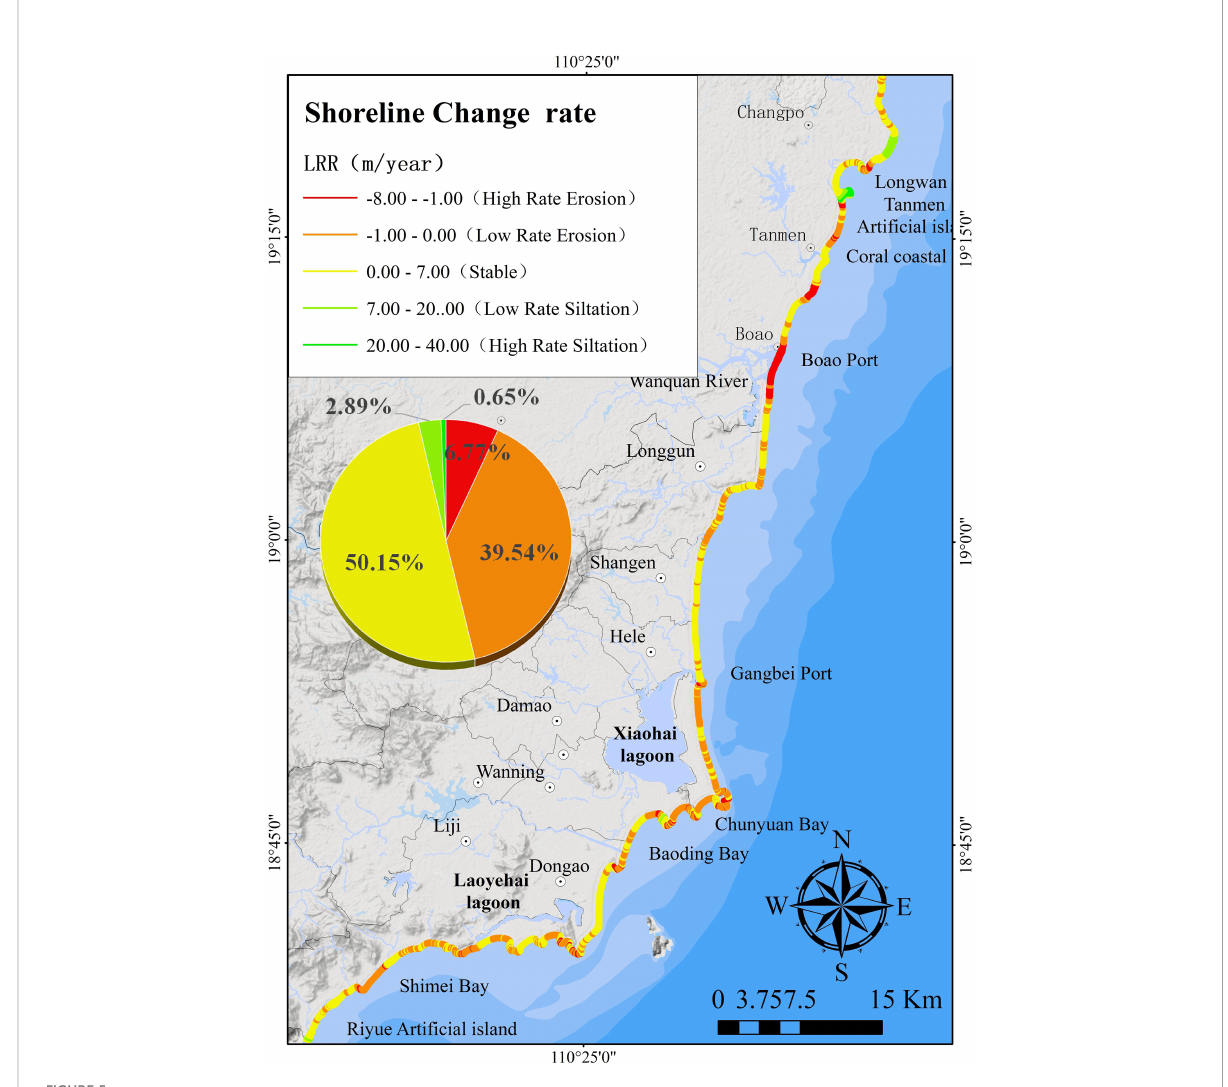
FIGURE 5 Distribution characteristics and proportion of Qionghai-Wanning coastline change rate from 1985 to